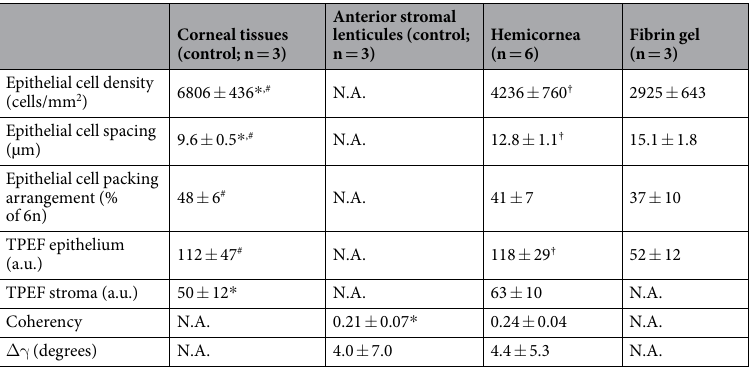
Table 1. Main results (mean ± SD) of the two-photon fluorescence (TPEF) and second harmonic generation (SHG) signals used for evaluating the hemicornea and fibrin gel in comparison with donor human corneal tissues. 6n: hexagonal Voronoi tiles. N.A.: not applicable. * P ≤ 0.05 between control and hemicornea . # P ≤ 0.05 between control and fibrin gel. † P ≤ 0.05 between hemicornea and fibrin